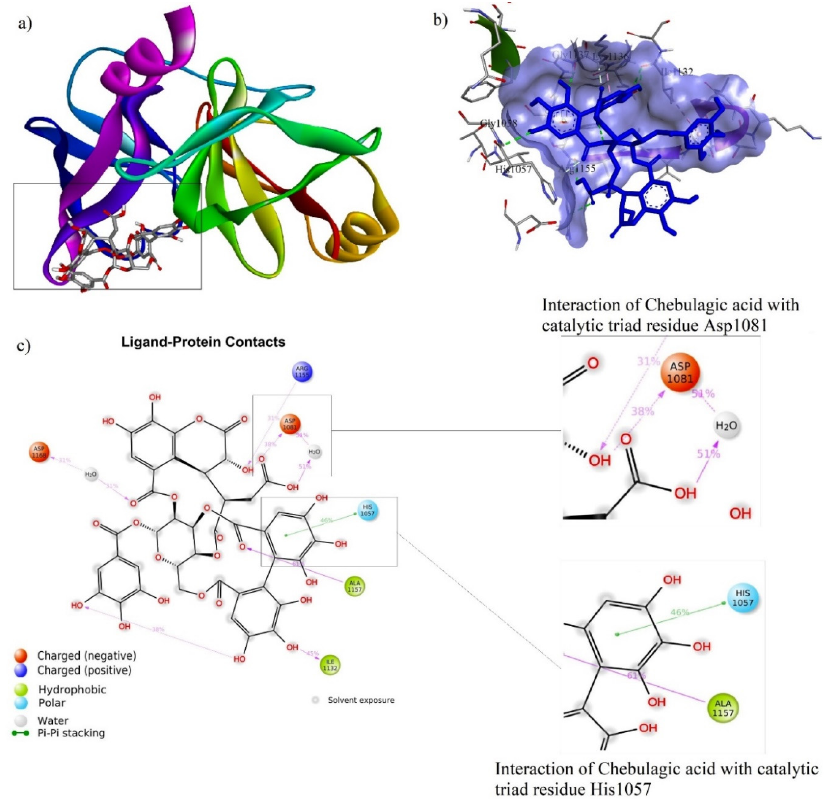
Figure 7. Intermolecular interactions of chebulagic acid with NS3/4A. ( a ) Chebulagic acid at catalytic triad residue site; ( b ) chebulagic acid bound to NS3/4A binding pocket; ( c ) chebulagic acid interactions with catalytic triad residue Ser1139, His1057, and Asp1081.